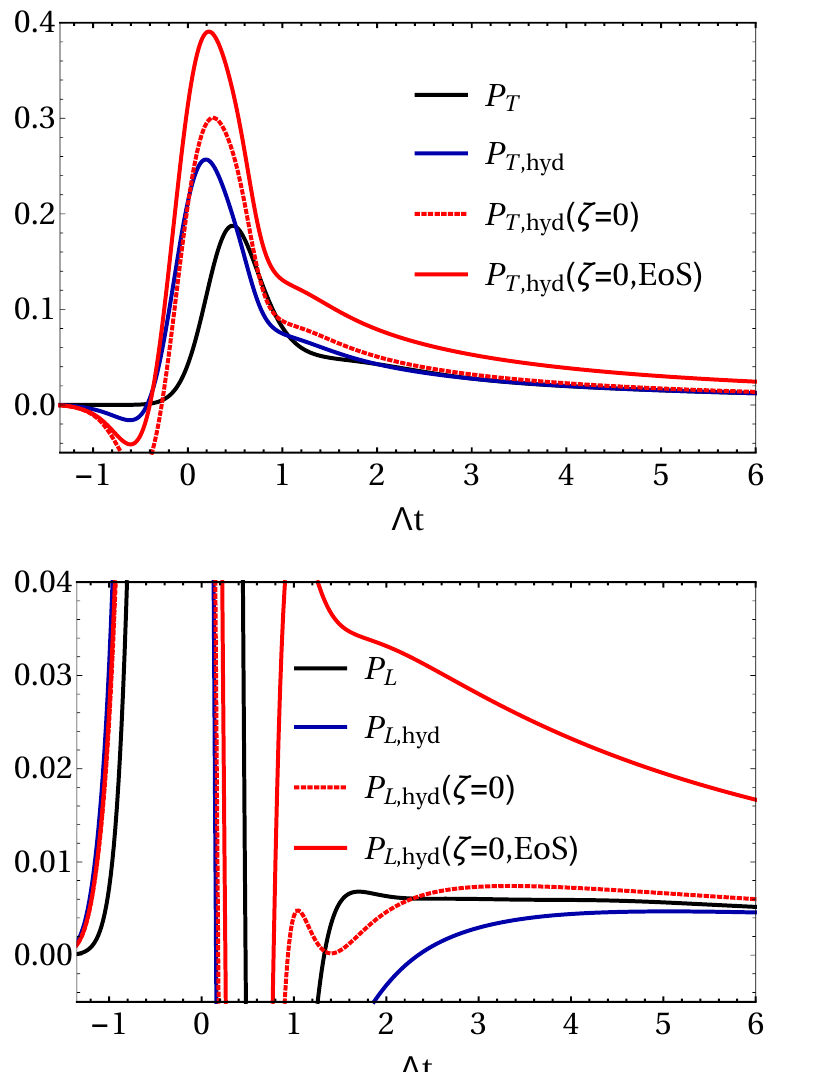
Figure 7 . Time evolution of the pressures, in units of (cid:3) 4 , for (cid:30) = 20, (cid:22)= (cid:3) = 0 : 77 and (cid:22)! = 0 : 30. M The evolution is compared to the hydrodynamic prediction via the constitutive relations Equa- tion (5.2) in di(cid:11)erent approximations: P hyd ( (cid:16) = 0 ; EoS) corresponds to a conformal (cid:13)uid with L;T P eq = E = 3 and (cid:16) = 0; P hyd ( (cid:16) = 0) includes the correct, non-conformal equation state but still f L;T g (cid:16) = 0; P hyd includes the correct, non-conformal equation of state and the non-vanishing (cid:16) . and L;T including all non-conformal dynamics P hyd . After a time t (cid:3) = 2 : 12 (4 : 65) the transverse (lon- L;T gitudinal) pressure is described by non-conformal hydrodynamics with better than 10% accuracy.